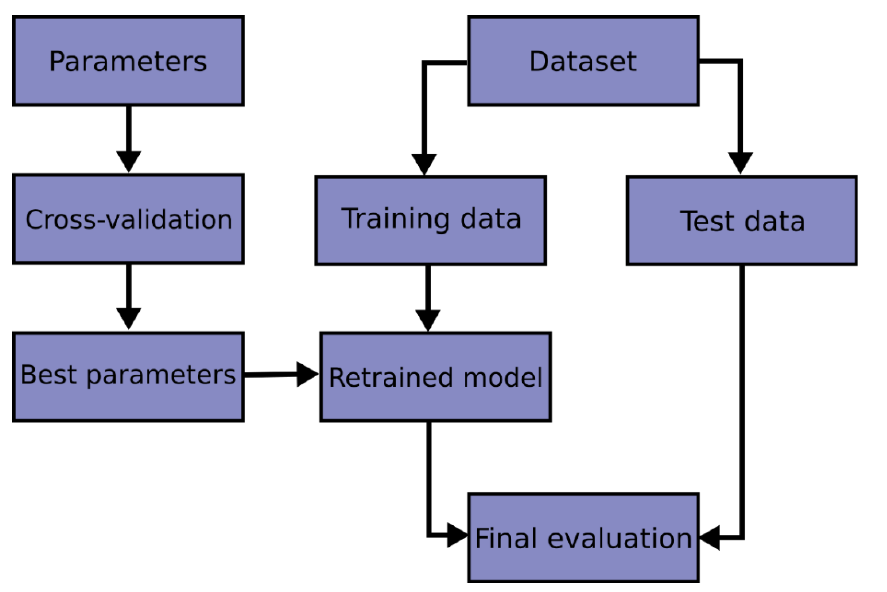
Figure 2. Flowchart indicating the actual processing steps followed in multivariate linear regression analysis.